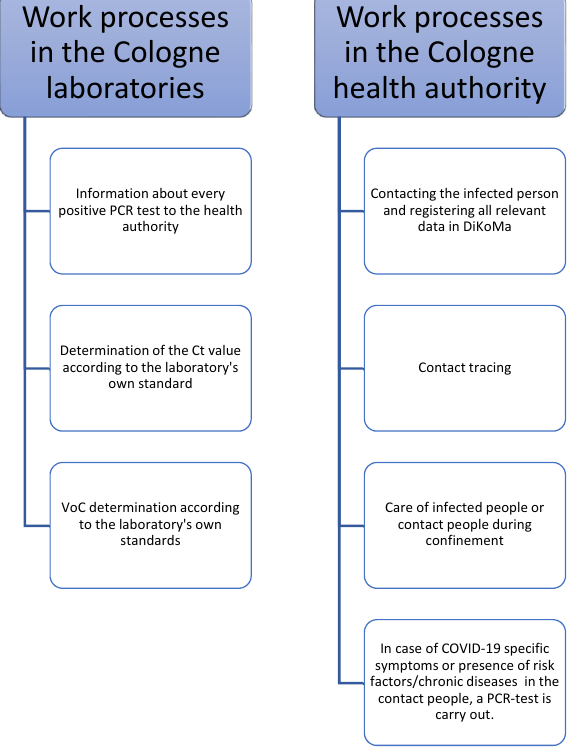
Figure 1. Operational procedures in the Cologne Health Department and Cologne laboratories.